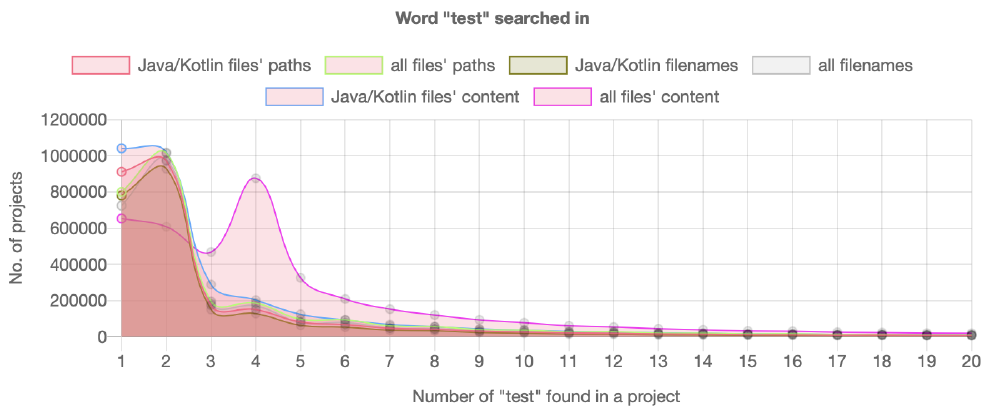
Figure 2. The number of occurrences of the word “test” for all Java primary language projects at GitHub.